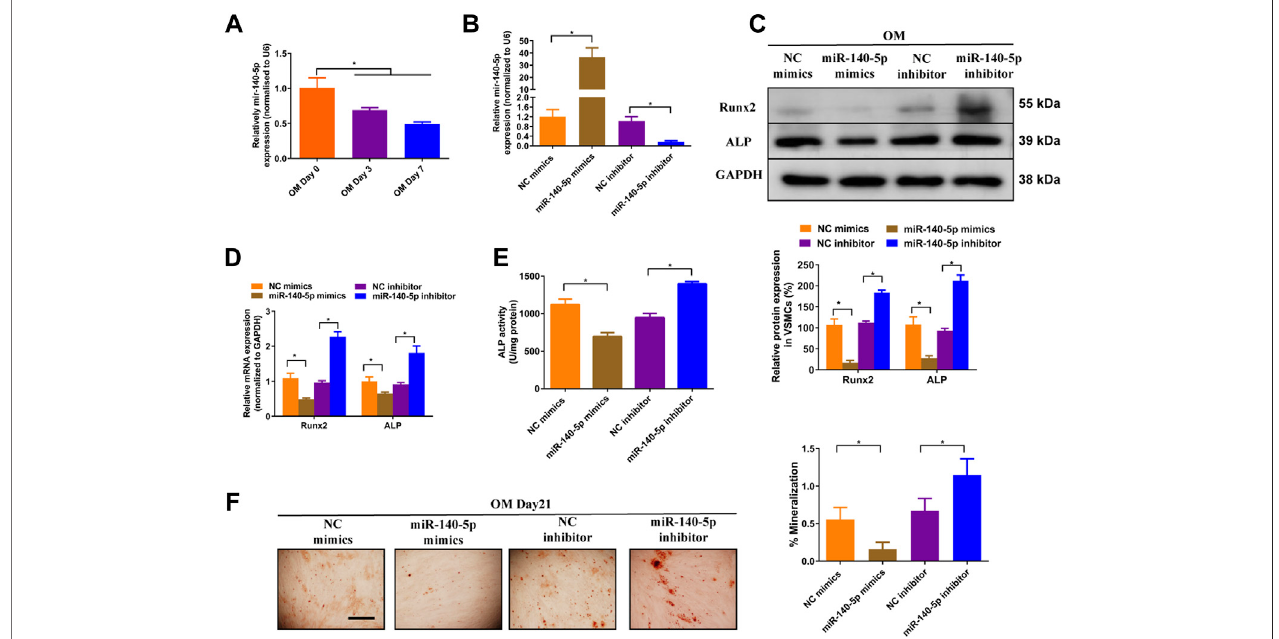
FIGURE 3 | miR-140-5p antagonises osteogenic differentiation of VSMCs. (A) qRT-PCR was performed to evaluate the expression of miR-140-5p in VSMCs culturedinOM medium. (B) qRT-PCRwasperformedtoevaluatethe expression ofmiR-140-5p in VSMCs transfected withspeci fi cmiR-140-5p mimics orinhibitor. (C) Western blotting was performed to determine the protein expression of Runx2 and ALP in VSMCs transfected with speci fi c miR-140-5p mimics or inhibitor. The data were presented as densitometric ratios normalized to GAPDH [ (C) , lower panel]. (D) qRT-PCR was performed to determine the protein expression of Runx2 and ALPinVSMCstransfected withspeci fi cmiR-140-5pmimicsorinhibitor. (E) TheALPactivitywasevaluatedbyspeci fi cElisakitsinVSMCs transfectedwithspeci fi cmiR- 140-5p mimics or inhibitor. (F) Alizarin Red S staining were measured in ß -GP-treated VSMCs transfected with speci fi c miR-140-5p mimics or inhibitor for 21 days. Representativemicroscopicviewsareshown.Scalebarrepresents200 µm.Datawerepresentedasratioofpositivestainingarea[ (F) ,rightpanel].Eachexperimentwas repeated for three times. The data represent the mean ± SD of triplicates. * p < 0.05.